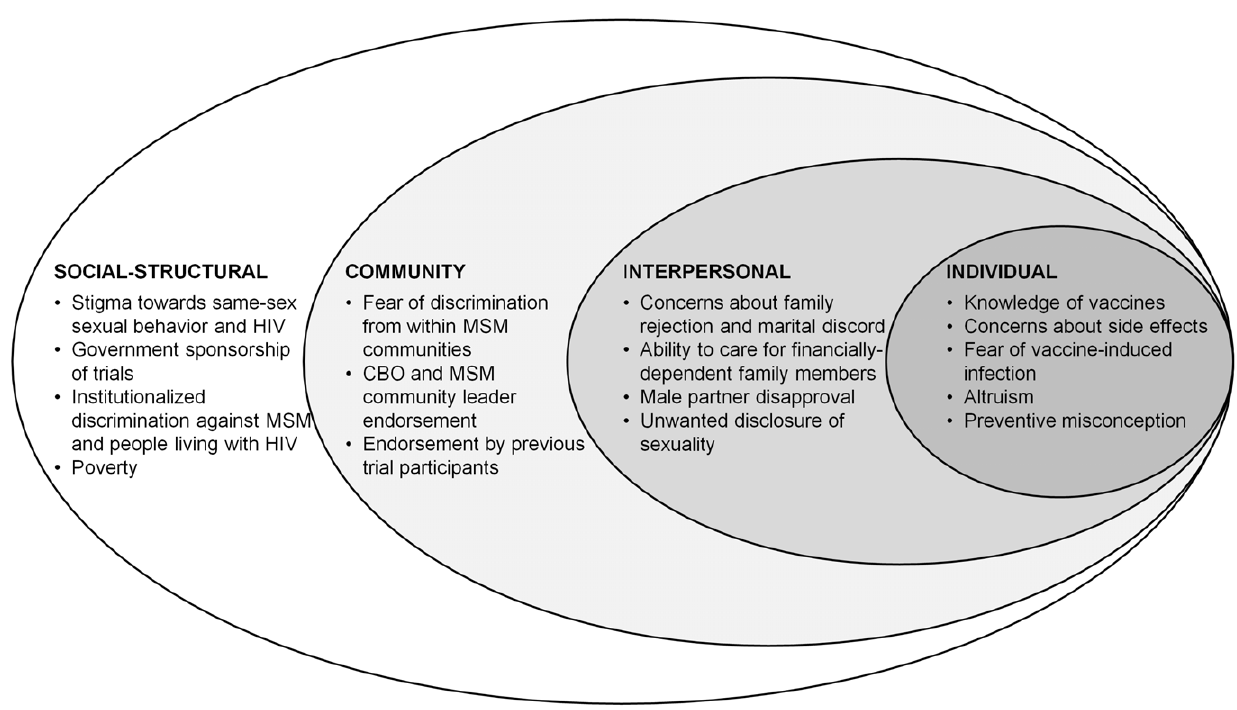
Figure 1. A social ecological model of willingness to participate in HIV vaccine trials among MSM in Chennai and Mumbai, India (n=82). Note: CBO=community-based organization MSM=men who have sex with men.